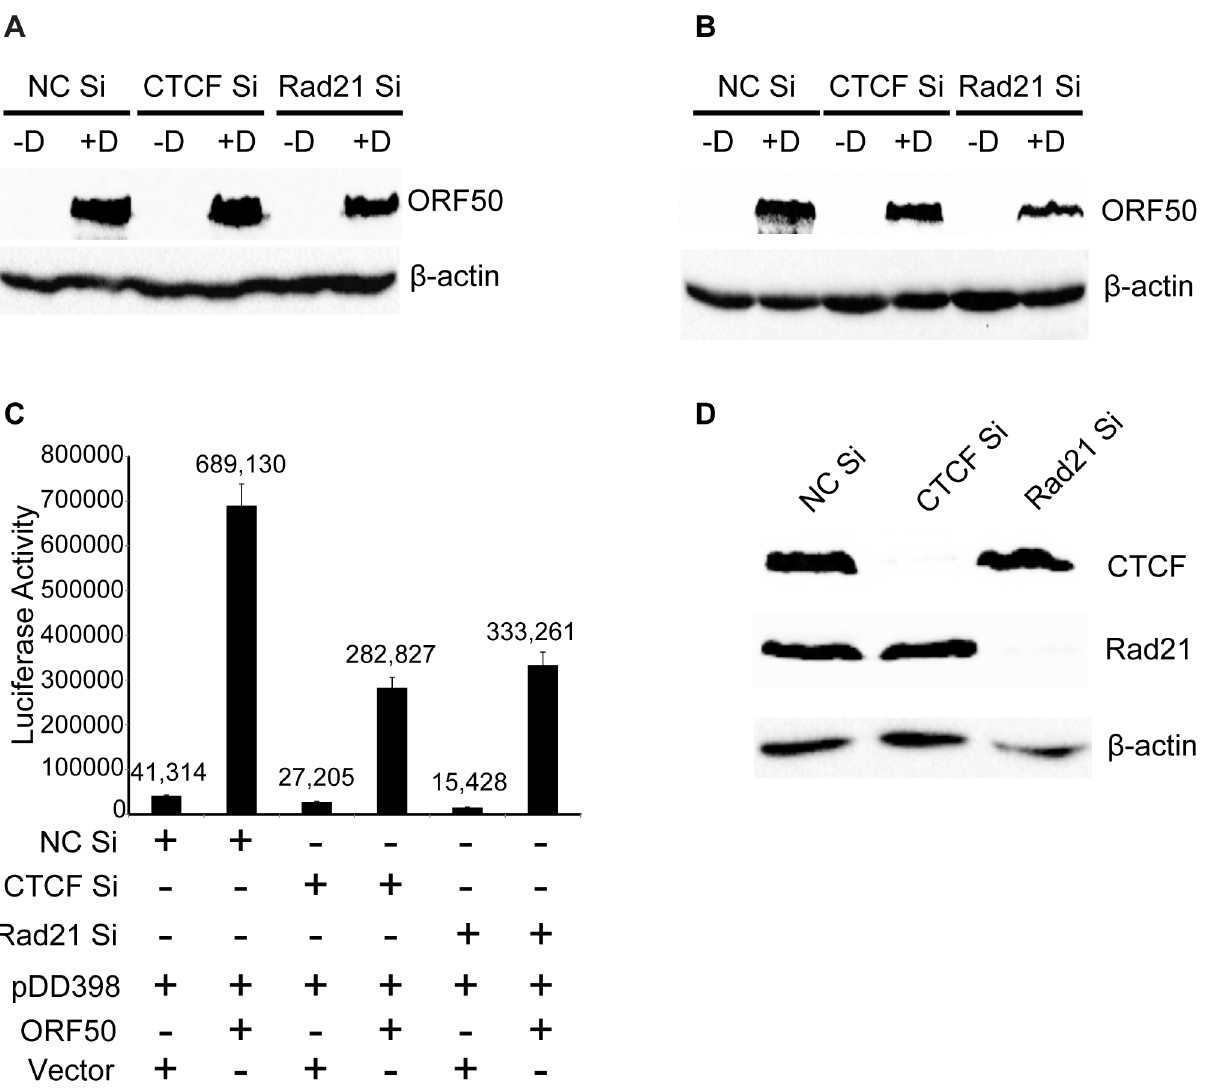
Figure 8. Lack of CTCF or Rad21 effect on ORF50/RTA levels or ORF50/RTA activation function. A. KSHV-infected iSLK cells were induced to replicate after control KD (NC Si), CTCF KD (CTCF Si) or Rad21 KD (Rad21 Si). Cells were either induced to permit KSHV replication with doxycycline ( + D) or mock-induced ( 2 D). Protein lysates were prepared at 24 hours post-induction and blotted with anti-ORF50/RTA antibodies. B. Samples were prepared from cells treated as in (A) above but harvested at 48 h post-induction and analyzed by immunoblotting with ORF50/RTA antibodies. C. Effect of CTCF or Rad21 depletion on ORF50/RTA transcriptional activation function. 293 cells were depleted of CTCF (CTCF Si) or Rad21 (Rad21 Si) by siRNA transfection or transfected with a negative control siRNA (NC Si). 48 h after siRNA transfection, cells were transfected with an ORF57 promoter- luciferase reporter plasmid (DD398) and either ORF50 expression plasmid (ORF50) or empty vector (vector). Luciferase assays were performed 48 h after transfection and are expressed as relative luminescence units. D. Lysates of cells used for luciferase assays in (C) above were immunoblotted with anti-CTCF or anti-Rad21 antibodies to confirm complete depletion.